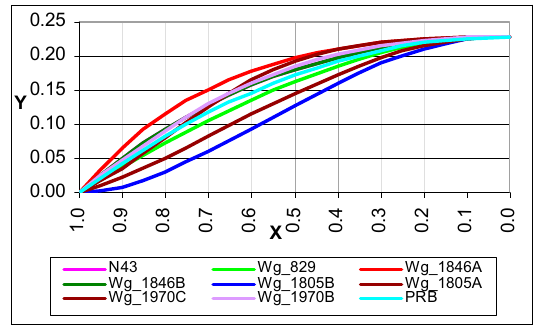
Figure 11. Main waterlines of Wigley’s models.